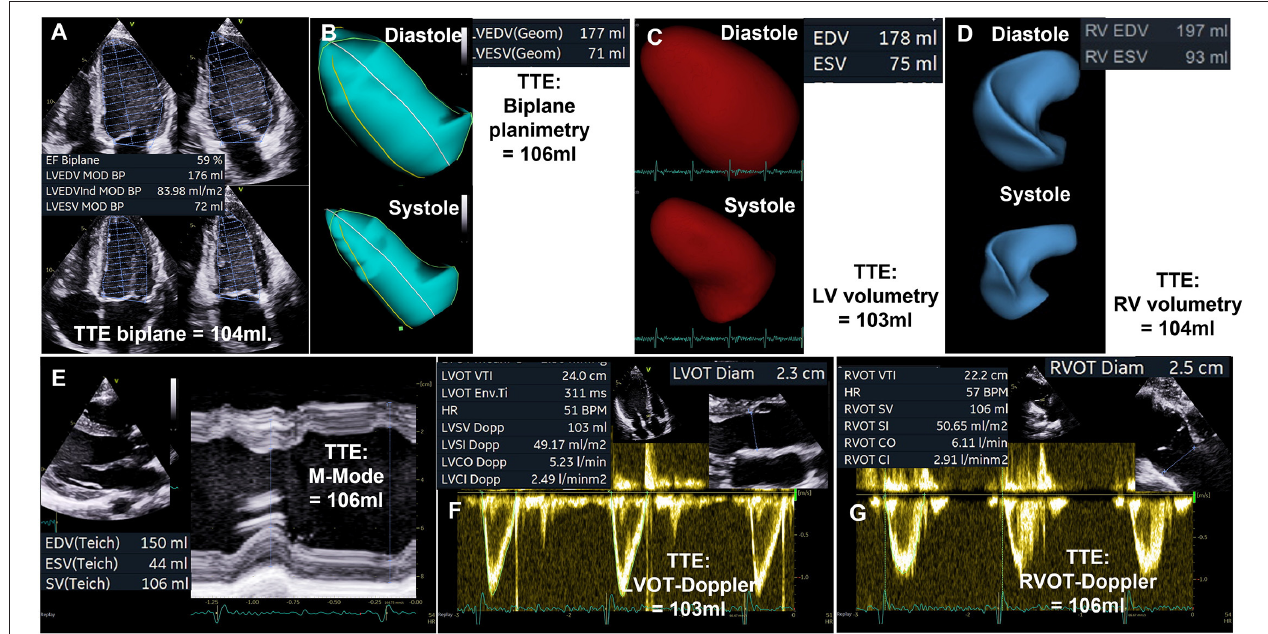
FIGURE 2 | Illustration of comparable quantitative assessment of left ventricular stroke volume (LVSV) by different echocardiographic modalities. (A) Biplane planimetry of the left ventricle (LV). (B) Triplane LV planimetry. (C) LV volumetry by 3D transthoracic echocardiography (TTE). (D) Volumetry of the right ventricle (RV) by 3D-TTE. (E) LVSV determination by M-Mode analysis. (F) LVSV assessment by measurement of blood flow velocities in the left ventricular outflow tract (LVOT). (G) RV stroke volume (RVSV) assessment by measurement of blood flow velocities in the right ventricular outflow tract